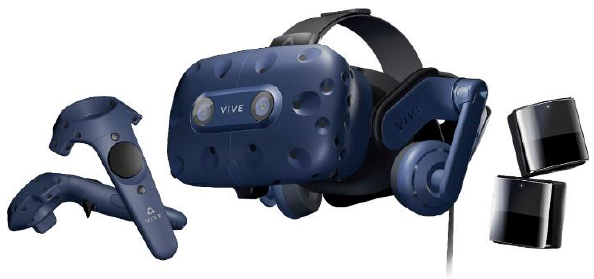
Figure 1. HTC Vive Pro with controllers and